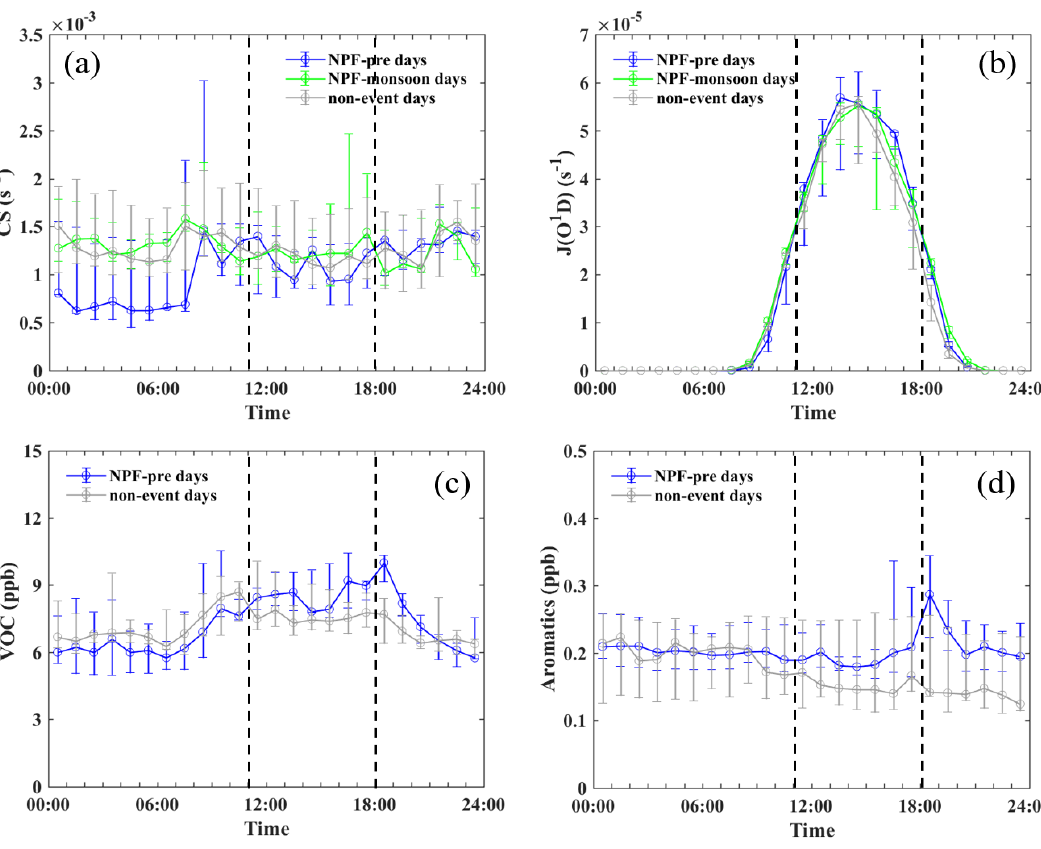
Figure 3. Diurnal variations of (a) condensation sink (CS), (b) J O 1 D, the total concentration of (c) VOC and (d) aromatics in NPF-pre days, NPF-monsoon days and non-event days. The upper and lower bars indicate the 75th and 25th percentiles; the markers are the average values.